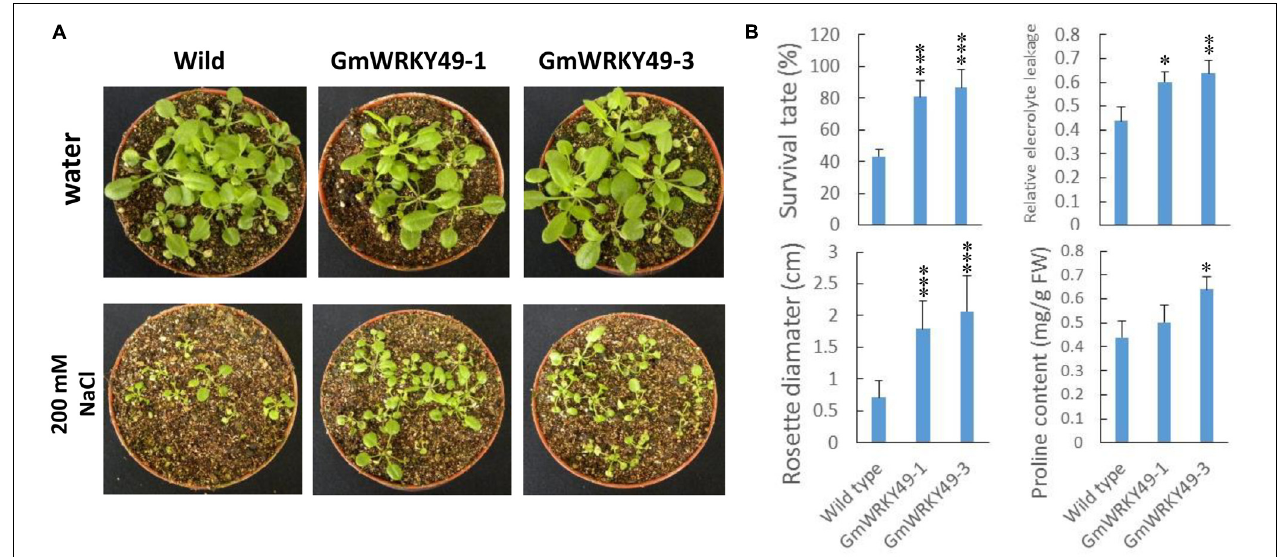
FIGURE 4 | Salinity tolerance of transgenic Arabidopsis plants overexpressing GmWRKY49. (A) Response of WT and GmWRKY49 transgenic Arabidopsis plants under control and saline conditions. (B) Survival rate, rosette diameter, relative electrolyte leakage, and proline content differences between WT and transgenic Arabidopsis plants in “c” under 200 mM NaCl treatment for 1 week. P -values were calculated using Student’s t -test and ∗ P < 0.05, ∗∗ P < 0.01, and ∗∗∗ P < 0.001 compared with